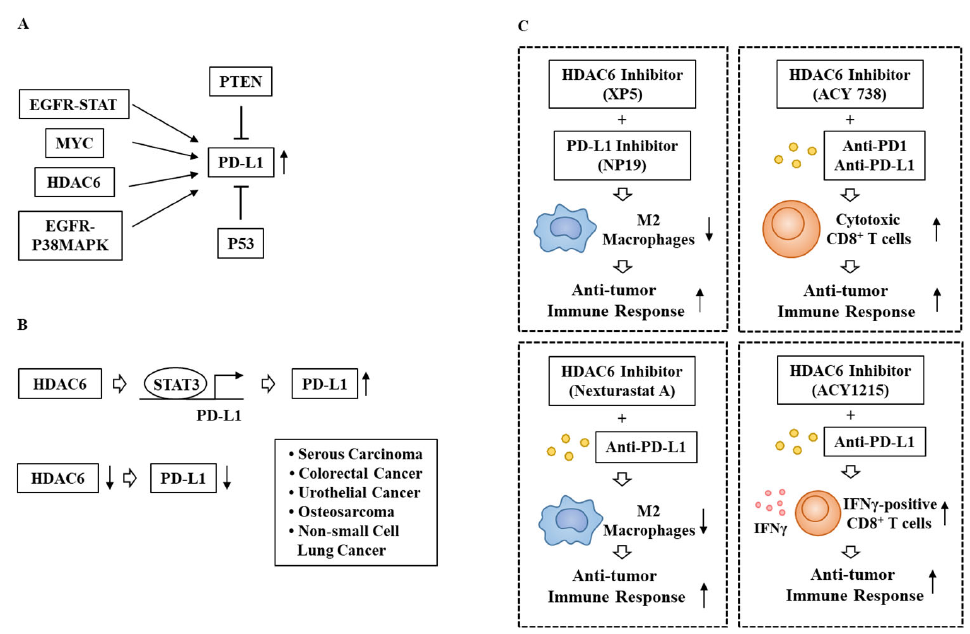
Figure 5. Expression regulation of PD ‐ L1 and effects of HDAC6 inhibitors on sensitivity of cancer cells to immune checkpoint inhibitors. ( A ) EGFR signaling, MYC, and HDAC6 increase the expres ‐ sion of PD ‐ L1. PTEN and P53 negatively regulate PD ‐ L1 expression. ( B ) Downregulation of HDAC6 decreases the expression of PD ‐ L1. ( C ) HDAC6 inhibitors enhance sensitivity of cancer cells to im ‐ mune checkpoint inhibitors by increasing activated CD8 + T cells while decreasing tumor promoting M2 macrophages. ↓ denotes negative regulation; ↑ denotes positive regulation; → denotes increases in transcription; T bar arrows denote negative regulation; and hollow arrows denote direction of reaction.